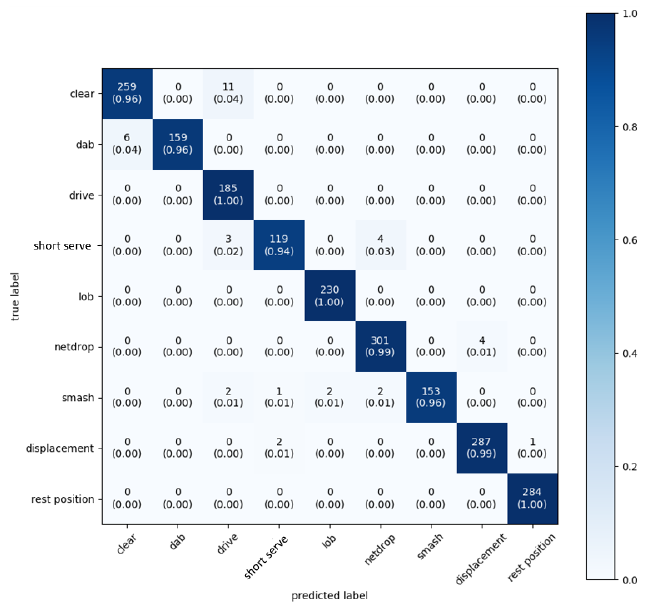
Figure 8. Novel weights-based neural network architecture. Confusion matrix: accelerometer and gyroscope data. A sampling frequency of 100 Hz and ensemble learning with extra weights are used. The average accuracy is 98%.